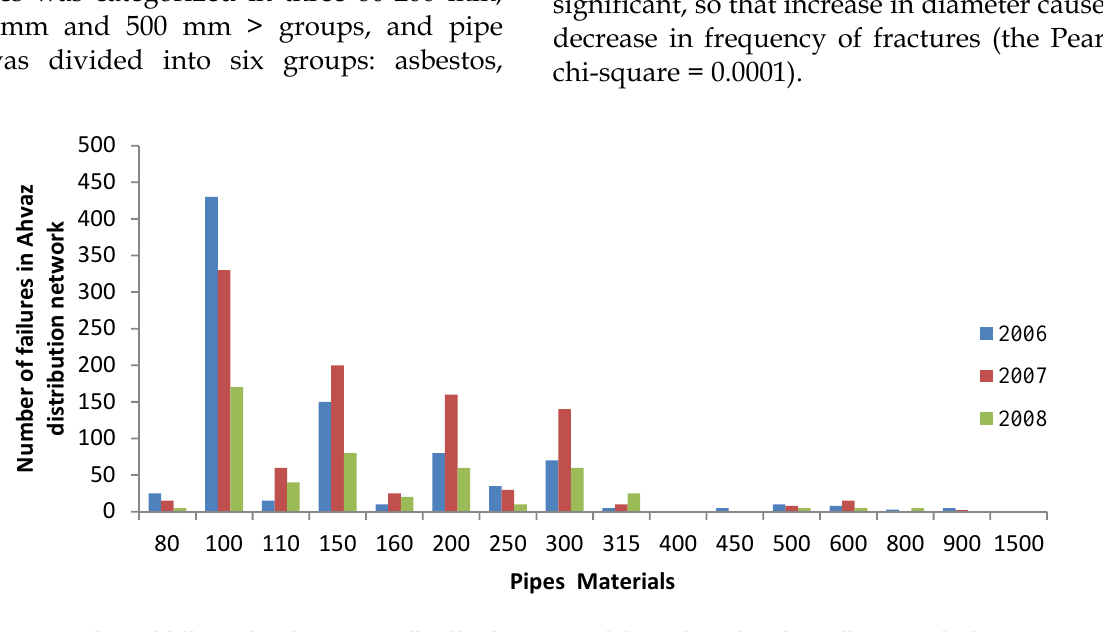
Figure 3. Number of failures in Ahvaz, Iran distribution network based on the pipes diameter during